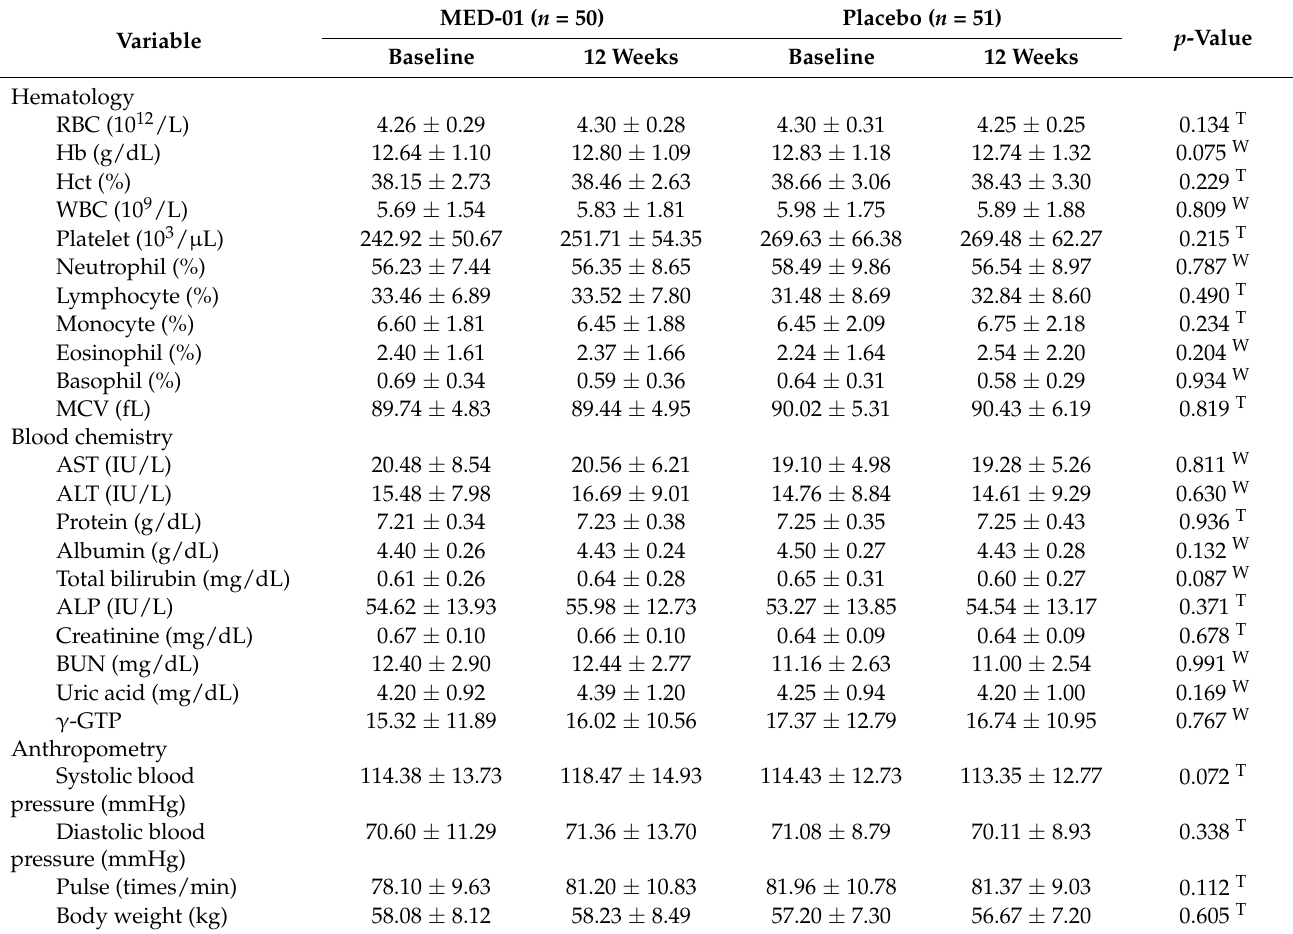
Table 4. Safety assessment before and after 12 weeks of MED-01 and placebo